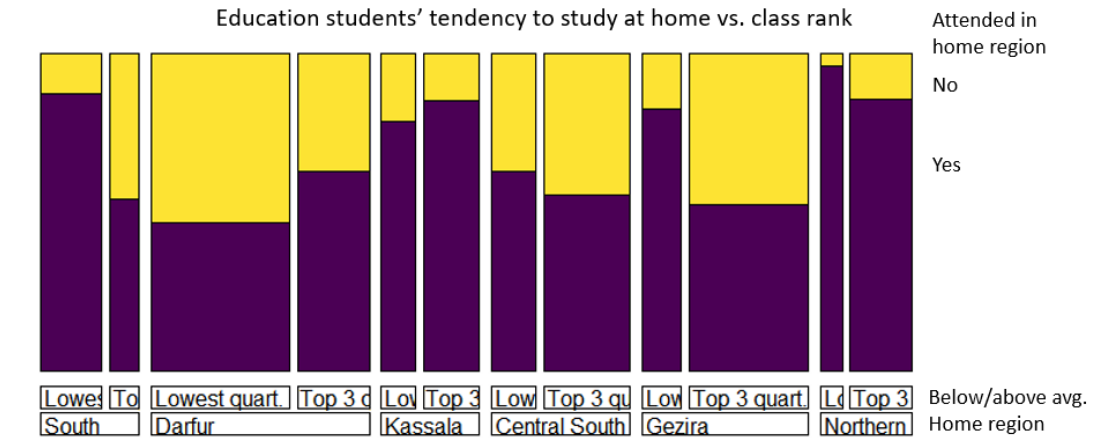
Figure 25. Double-decker plot showing proportions of bachelor’s students in education who study in their home regions, for lowest-quartile and top three quartile students.